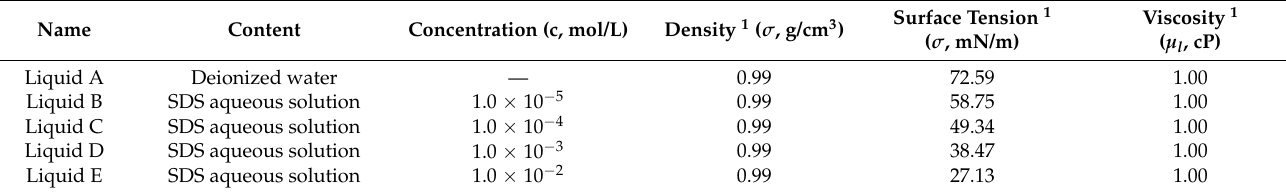
Table 1. Physical characteristics of liquid